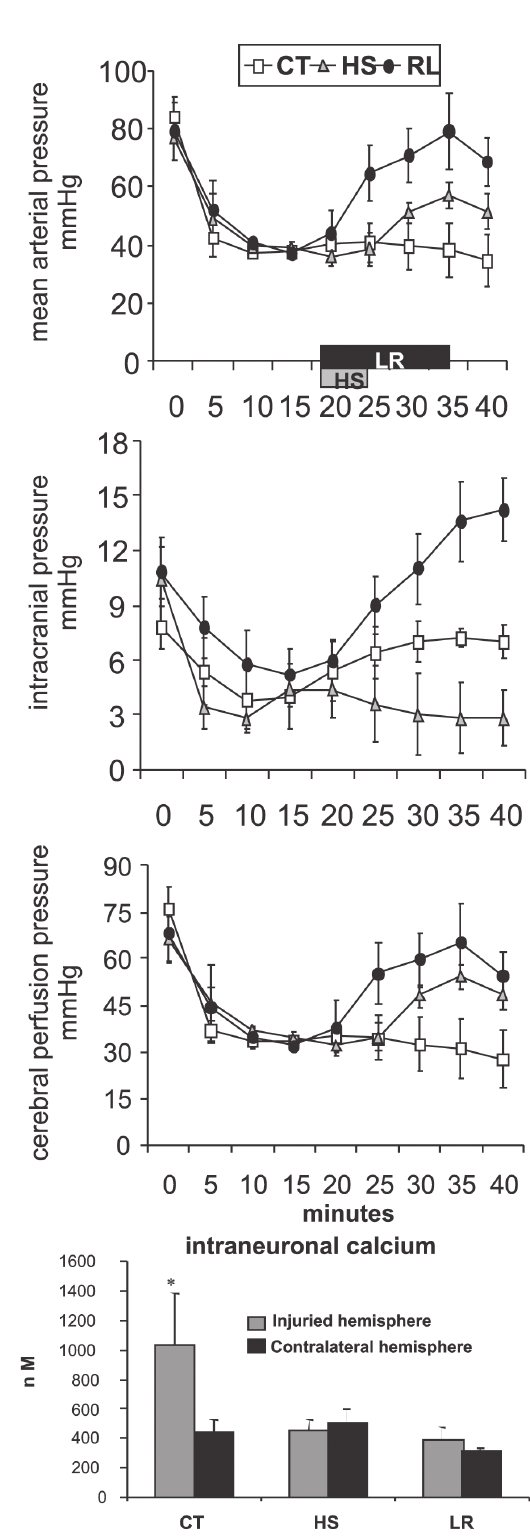
Figure 6 - Mean arterial, intracranial and cerebral perfusion pressures in hemorrhaged dogs sustaining an unilateral cerebral cryogenic lesion for the CT group (no fluids), HSD group (4 mL/kg over 5 min), and the LR group (32 mL/kg over 15 min). Intraneural calcium measured from cerebral byopsies from the penumbra area and contralateral hemisphere. Adapted from Balbino, 2001.